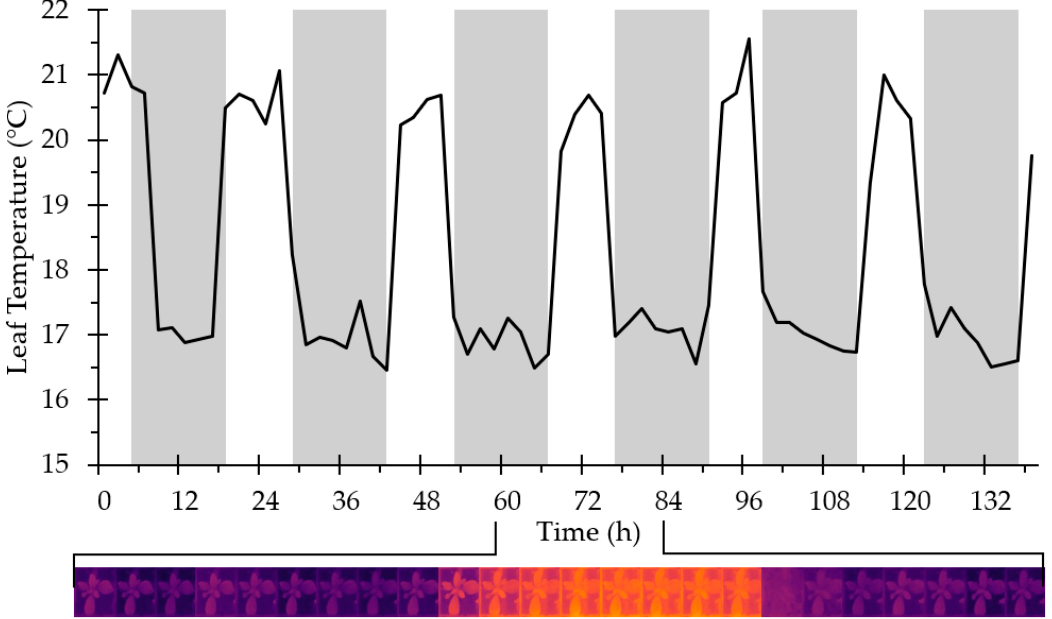
Figure 4. Leaf temperatures of Arabidopsis thaliana rosettes recorded using the Thermal Imager. In total, 48 plants were imaged every 30 min for 136 h. For clarity, data for a single plant are shown (mean of three spot measurements) at 2 h intervals. Dark bars show the night photoperiod. Inset: hourly thermographs for the marked 24 h period.